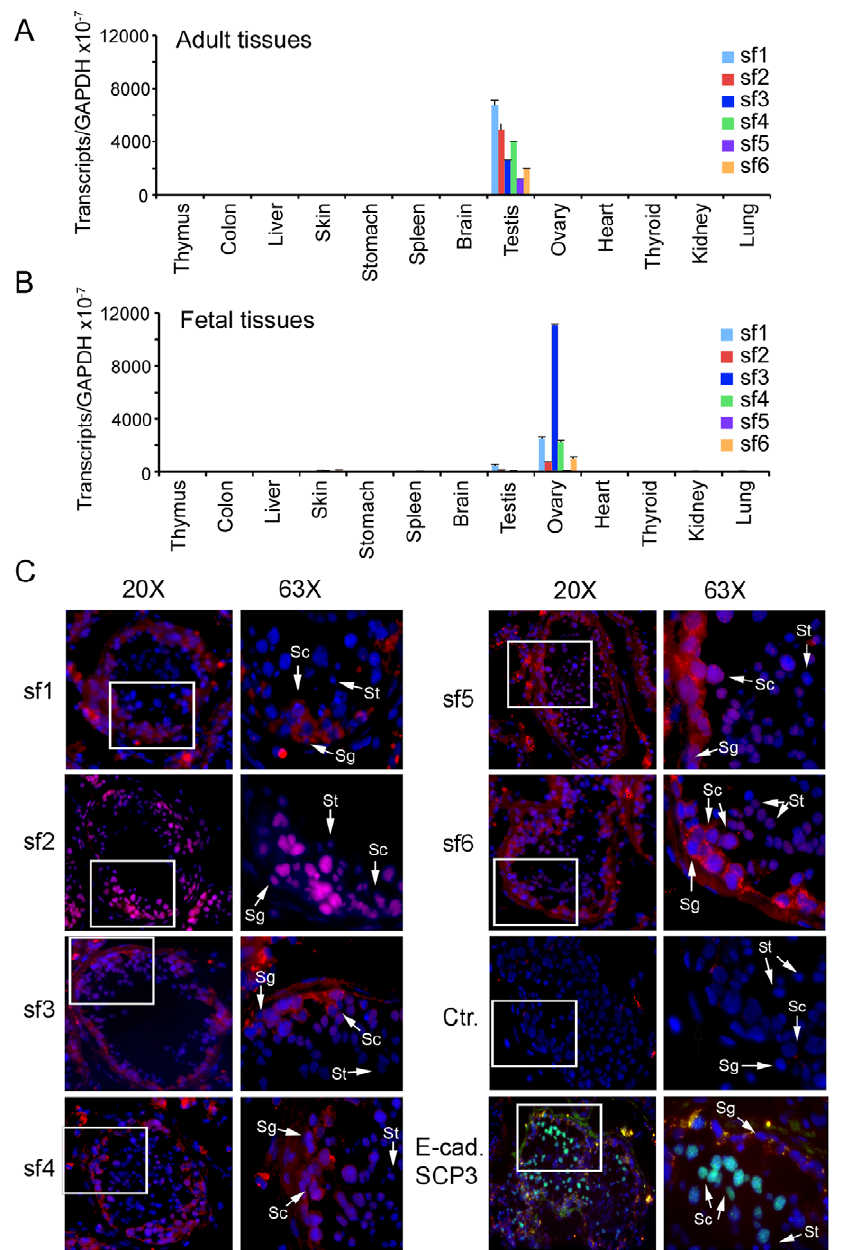
Figure 4. Expression of BORIS alternative transcripts in male and female gonads. qRT-PCR analysis of BORIS isoform expression in normal human adult ( A ) and fetal ( B ) tissues, respectively, was quantified by the absolute quantification approach. The 23 BORIS isoforms were divided into 6 subfamilies based on their unique 3 9 end sequences to enable the design of Taqman probes (Material and Methods). ( C ) BORIS isoform expression in human normal adult testis analyzed by in situ hybridization, RNA FISH. For FISH assays, the probes for six BORIS subfamilies (sf1–sf6) were labeled with digoxygenin-11-dUTP by PCR and individually hybridized to formaldehyde-fixed adult human testis. The slides were incubated with anti-DIG antibodies overnight and then visualized with rhodamine-conjugated secondary antibody. To identify spermatogonia and spermatocytes, we performed immunostaining with antibodies against SCP3 (red) and E-cadherin (light green), respectively. Merged images of DAPI-stained nuclei (blue) and BORIS isoform RNA (red) taken with 20X magnification; higher magnification images are 63X. Arrows with letters indicate: Sg- spermatogonia, Sc – spermatocytes, St – spermatids (small, elongated cells with elongated nuclei, respectively). The control (Ctr) is staining with rhodamine-conjugated secondary antibody alone.